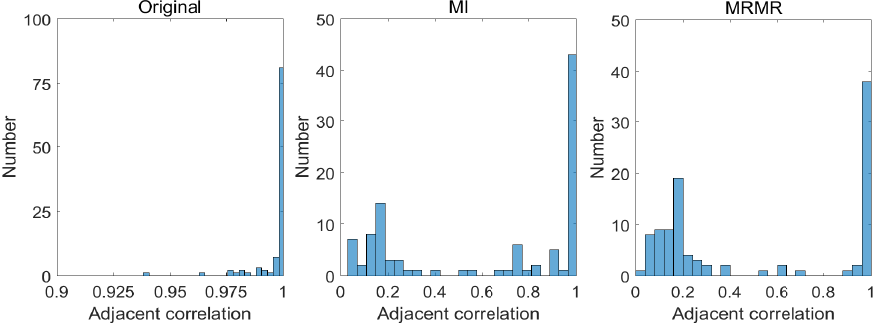
Figure 9. Correlation histogramsfor adjacent bands in original band order and rearranged band orders.